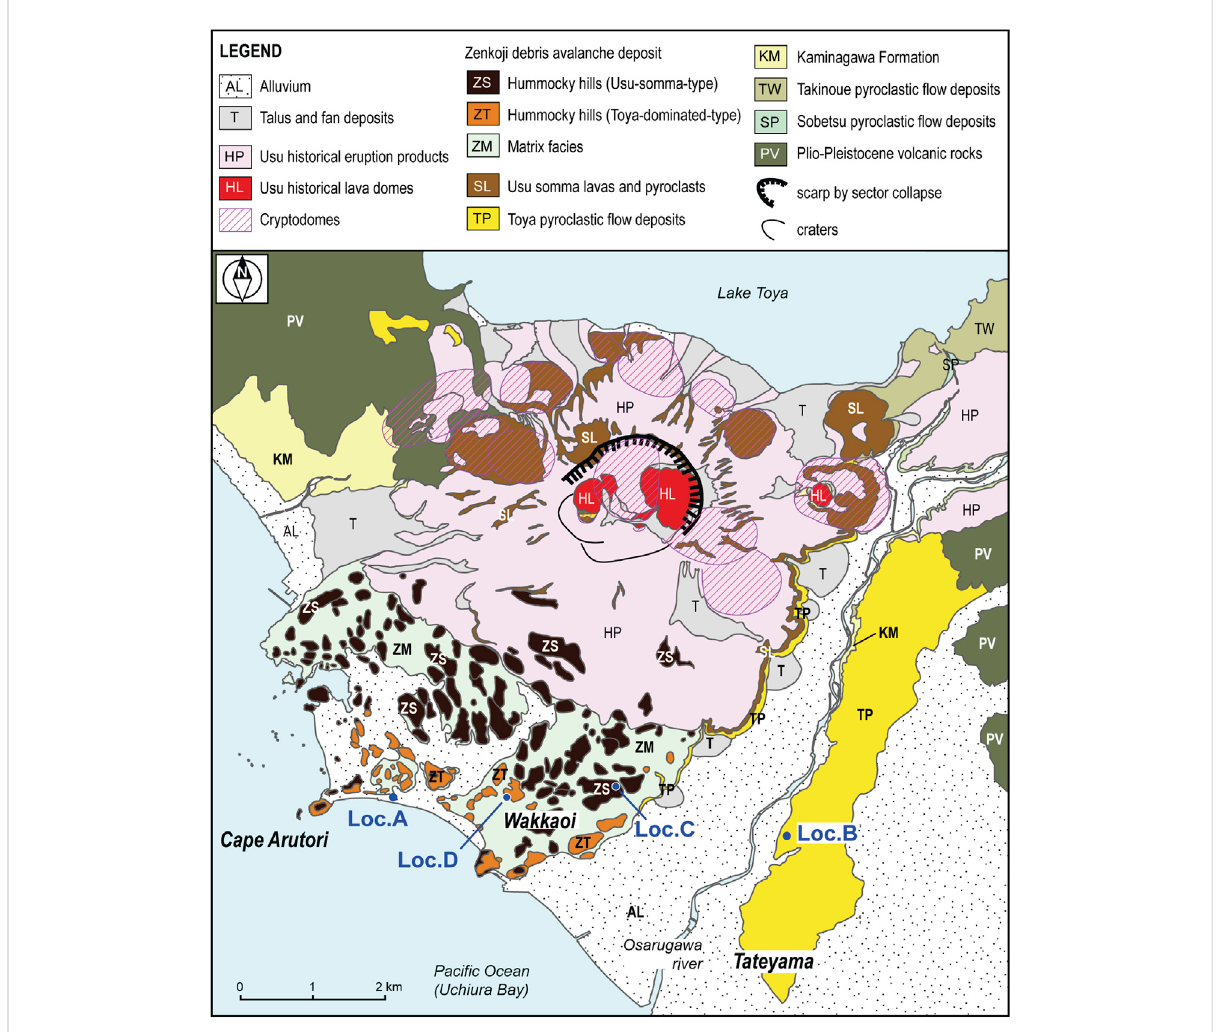
FIGURE 2 Geological map of Usu volcano, modi fi ed from Soya et al. (2007). Localities (A – D) on the map are the localities described in the text. Note that the distribution of the Kaminagawa Formation is limited to the west of Usu volcano and the base of the eastern cliff along the Osarugawa